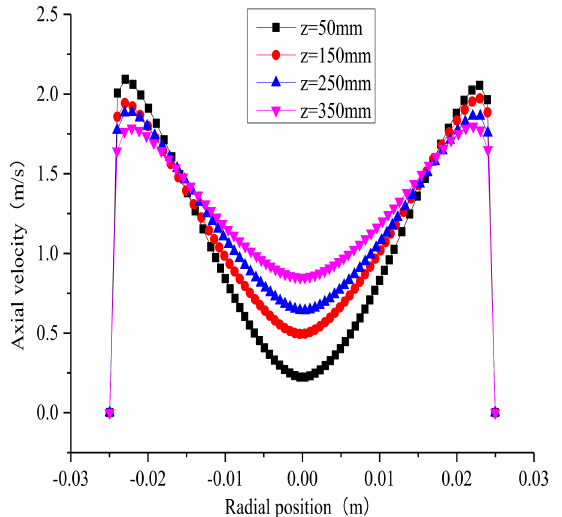
Figure 8. Radial distribution curves of axial velocity in different cross